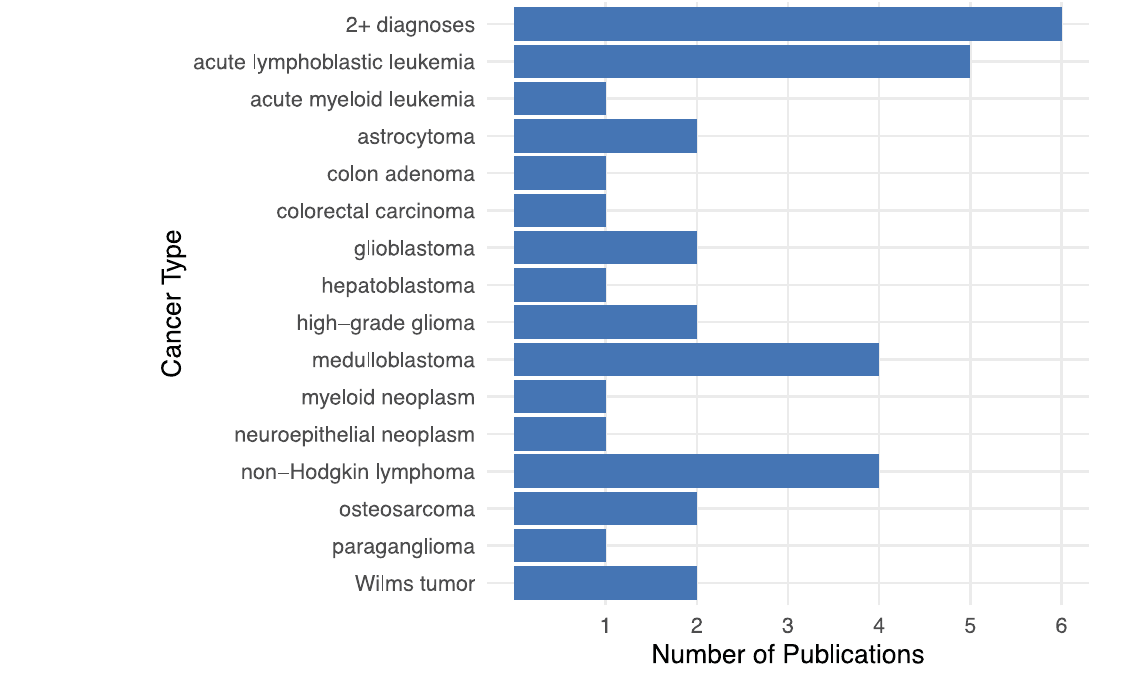
FIGURE 3 | The number of publications per cancer type pertaining to CH variants in pediatric cancer. The literature on CH variants has covered a wide range of cancer types, especially acute lymphoblastic leukemia, non-Hodgkin’s lymphoma, and medulloblastoma. In six publications, at least one patient was diagnosed with more than one cancer type. These “2 + diagnoses” include patients with the following cancer types: glioblastoma + non-Hodgkin’s Lymphoma + oligodendroglioma (Bakry et al., 2014), glioblastoma + rectal carcinoma (Bakry et al., 2014), glioblastoma + non-Hodgkin’s lymphoma (Chmara et al., 2013) or ALL + rectal adenoma ( Herkert et al., 2011), acute myeloid leukemia + medulloblastoma (Scott et al., 2007), colon carcinoma + oligodendroglioma (De Rosa et al., 2000), brain tumor + rhabdomyosarcoma (Quesnel et al.,